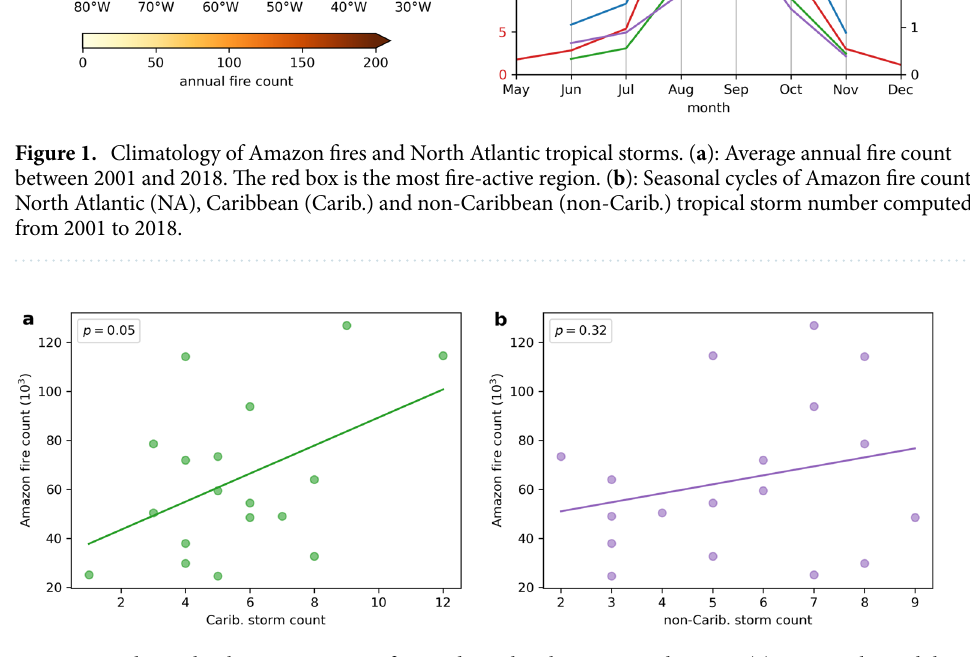
Figure 2. Relationship between Amazon fires and North Atlantic tropical storms. ( a ): Scatter plot with linear best fit of ASO Amazon fire count against ASO Caribbean tropical storm count in the years 2001–2018. ( b ): Same as ( a ) except for non-Caribbean tropical storm